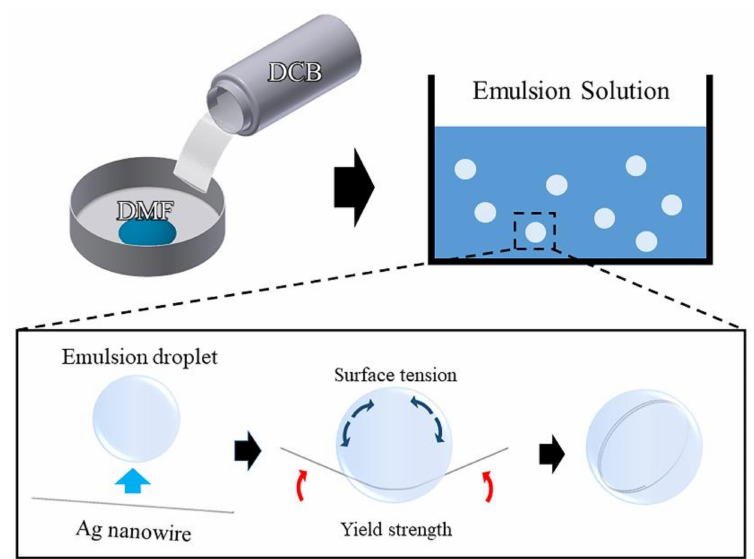
Figure 1. A schematic of the coiling nanowire inside a water-in-oil emulsion